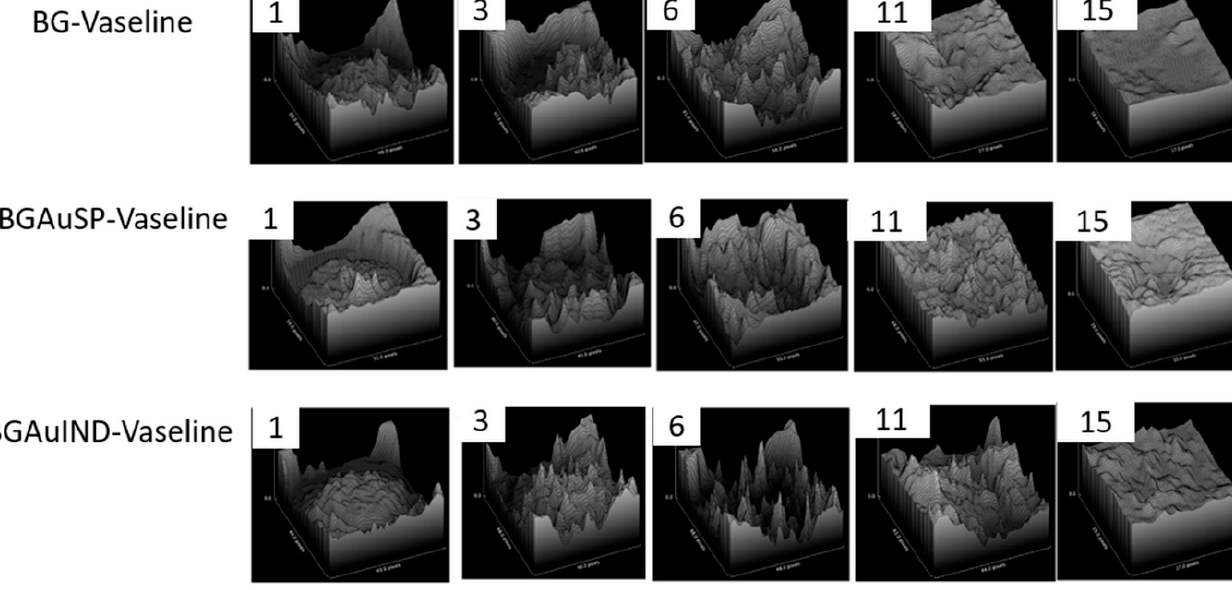
Figure 7. The evolution of wound healing presented in 3D at 1, 3, 6, 11, 15 post-surgery. (Scale bare 6 mm).